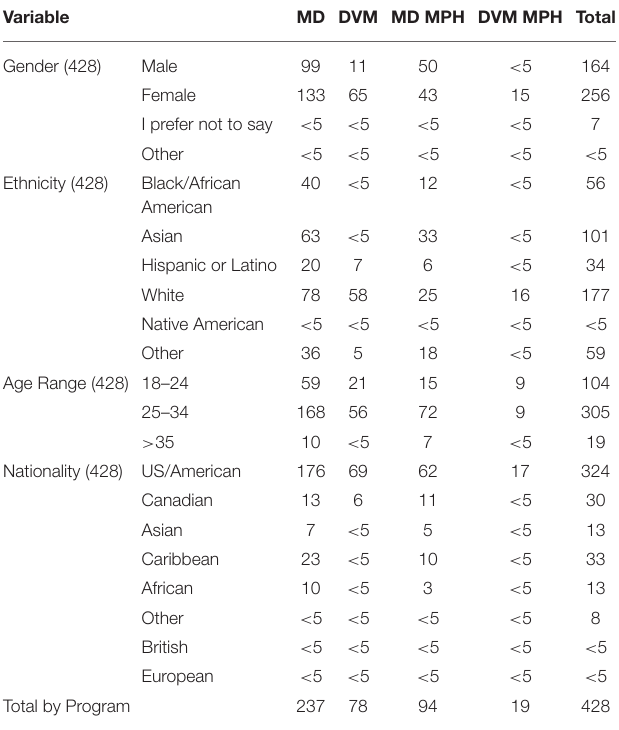
TABLE 2 | Demographics of student participants.